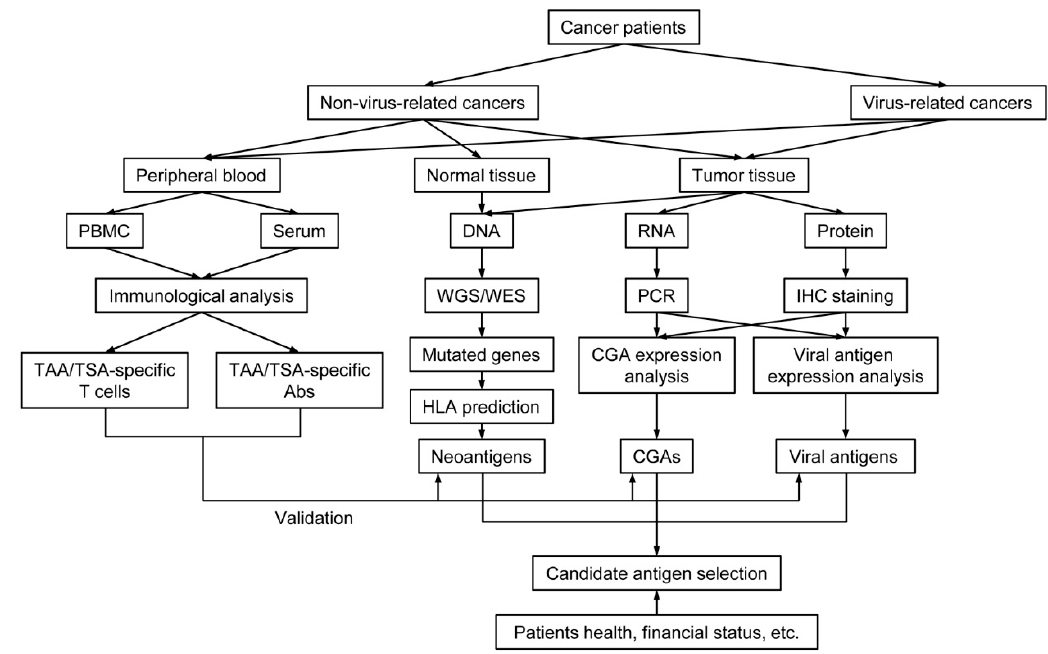
Figure 4. Methodology pipeline for antigen selection in cancer vaccine production. For patients with non-virus-related cancers, tumor biopsy samples and corresponding normal tissues are obtained and conducted to WGS/WES analysis for mutated genes. By using bioinformatic algorithms, neoantigens with high HLA binding affinity are selected from mutated proteins as candidate antigens for cancer vaccine design. Meanwhile, the expression of CGAs is determined by PCR and IHC (immunohistochemistry) staining methods in tumor tissues. CGAs with highly elevated levels are considered as candidates for vaccines. As for virus-related cancer patients, the first consideration for vaccine development is viral antigens. PCR and IHC staining are performed to evaluate the expression of viral antigens in the tumor biopsy. Based on the analysis results, elevated viral antigens are selected as candidate antigens for cancer vaccine manufacturing. Furthermore, immunological experiments should be carried out to access the specific T cells and antibodies against candidate antigens by using the peripheral blood sample from patients, validating the potential role of selected candidate antigens. After balancing patients’ health situation and financial status, a final decision concerning antigens for cancer vaccine development is made. PBMC—peripheral blood mononuclear cells.